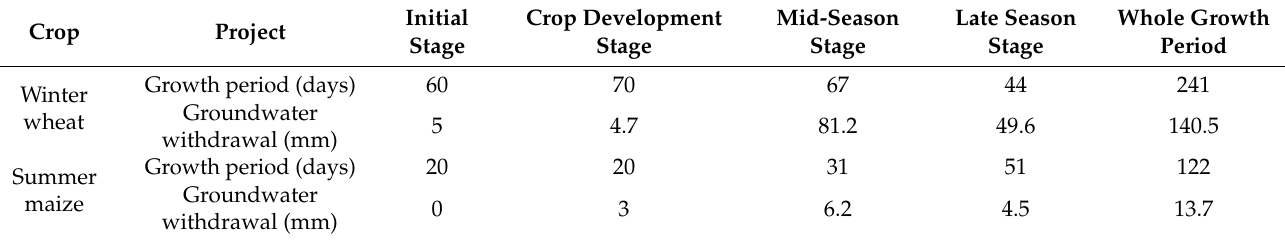
Table 4. The length of each growth period and the groundwater withdrawal for winter wheat and summer maize crops.